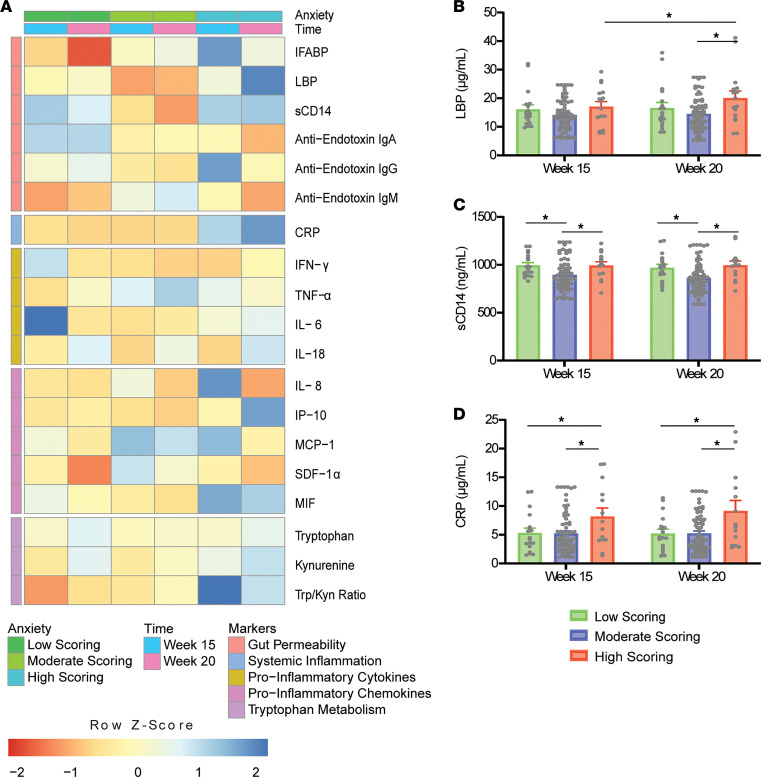
Differences in STAI-scoring groups across gestational time points in the healthy cohort (N = 18/70/16 from low/moderate/high).(A) Heatmap of normalized biomarker means across scoring groups and time points. Individual boxes are represented on a scale from red to blue. Darker red boxes represent markers whose concentrations were found to be greater than 1 standard deviation lower than the mean concentration across stress group and time point. Darker blue boxes represent markers whose concentrations were found to be greater than 1 standard deviation higher than the mean concentration across stress group and time point. Lower z scores are evident for intestinal fatty acid binding protein (IFABP) in the low-scoring group at 20 weeks. Higher z scores are evident for IL-6 in the low-scoring group at 15 weeks; for IFABP, anti-endotoxin IgG, IL-8, and tryptophan/kynurenine ratio (Trp/Kyn ratio) in the high-scoring group at 15 weeks; and for LBP, C-reactive protein (CRP), and IFN-γ–induced protein 10 (IP-10) in the high-scoring group at 20 weeks. Significant differences between STAI-scoring groups are illustrated for (B) LBP, (C) sCD14, and (D) CRP (2-way ANOVA with Tukey’s HSD). *P < 0.05. MCP-1, monocyte chemoattractant protein-1; MIF, macrophage migration inhibitory factor; SDF-1α, stromal cell-derived factor 1α.